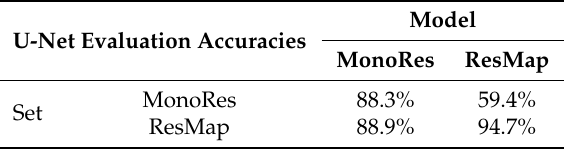
Table 6. U-Net model and evaluation set